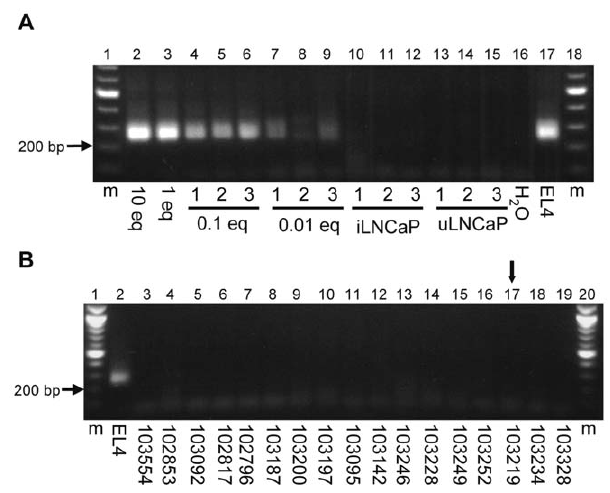
Figure 3. Detecting murine DNA by IAP PCR. PCR products were analyzed on 1.5% agarose gels containing ethidium bromide. (A) Sensitivity of the IAP PCR assay was determined by performing PCRs on titrations of EL4 murine cell line DNA in a background of 200 ng LNCaP DNA. One murine cell equivalent (1 eq) indicates 6 pg of EL4 DNA. XMRV-infected LNCaP (iLNCaP) and uninfected LNCaP (uLNCaP) were included as controls. (B) Screening results for 17 HIV-1 + patient samples. Arrow points to sample 103219, which tested positive for XMRV by non- nested gag PCR. (m) 100 base pair molecular weight marker, (EL4) 6 pg of murine EL4 cell line DNA without a background of human DNA.